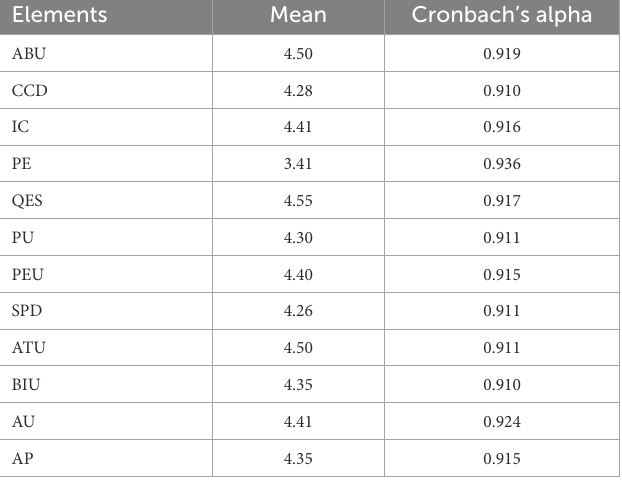
TABLE 4 Reliability of elements based on Cronbach’s